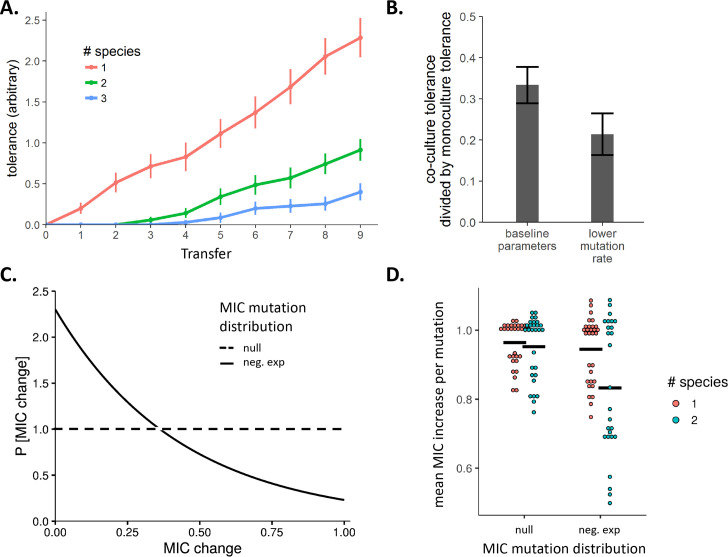
Simulation model of the evolution of antibiotic resistance in single-species vs. multi-species obligately dependent communities.A. A simulated evolution experiment with 35 replicate populations shows that increasing the number of interdependent species in a consortium results in a slower increase in the average MIC over time. Error bars represent the standard deviation among replicates. B. Effect of lower mutation rate on resistance evolution in model. Lower mutation rates result in bigger differences in the relative tolerance of one-species versus two species systems. C. Distributions from which MIC-altering mutations were randomly pulled. The x-axis is relative to the maximum MIC change possible in one mutation. The “null” model used a uniform distribution. The “neg exp” used a truncated negative exponential distribution with rate parameter 2.3, which kept 90% of random numbers less than the max MIC change of 1.0. D. Mean MIC increase conferred per mutation as a function of the mutation distribution and the number of species.